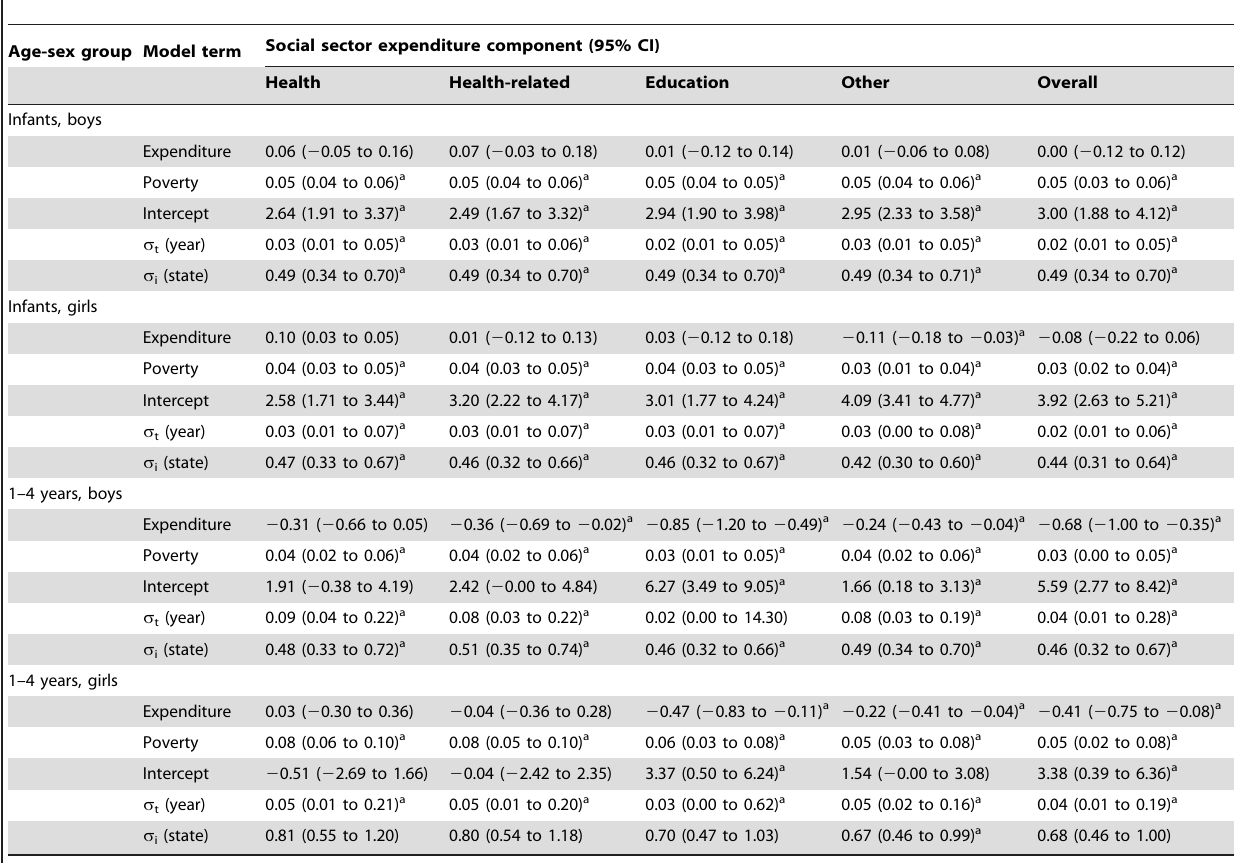
Table 1. Association of infant mortality rate and death rate for age 1–4 years with per-capita state social sector expenditure from 1997 to 2009, using a mixed-effects regression model.